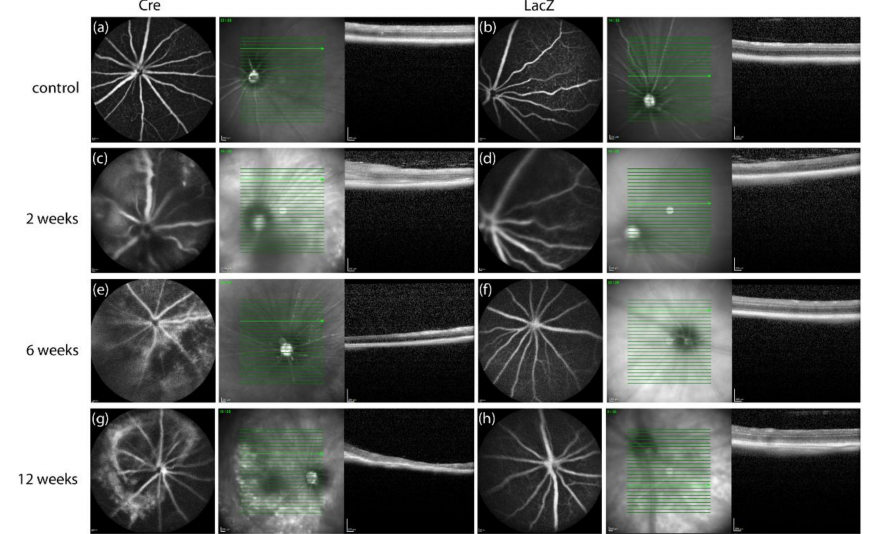
Figure 2. Fluorescein angiography (FA) and optical coherence tomography (OCT) images taken before gene transfer and after Cre and LacZ injections: ( a , b ) normal OCT and FA before injection, ( d , f , h ) normal OCT and FA after LacZ injection. ( c ) Diffuse hyperfluorescence seen in FA and thicker retina in OCT two weeks after Cre injection. ( e ) Hyperfluorescent and hypofluorescent areas in FA and thin retina in OCT six weeks after Cre gene transfer. ( g ) Hyperfluorescent circular area with hypofluoresence in the middle of FA image and thin and atrophic retina seen in OCT 12 weeks post- Cre injection.